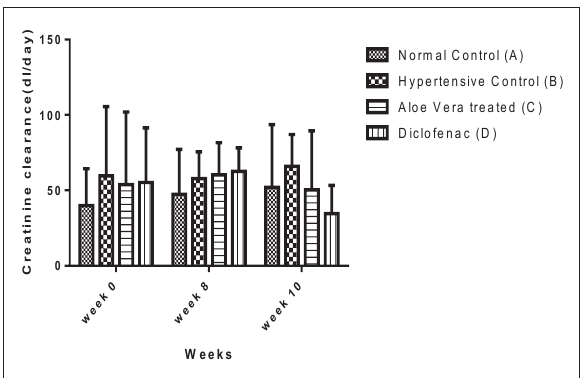
as shown in Fig-4.